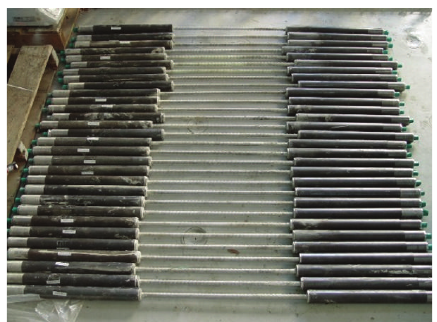
Figure 10: Preparation of gripping system [24].